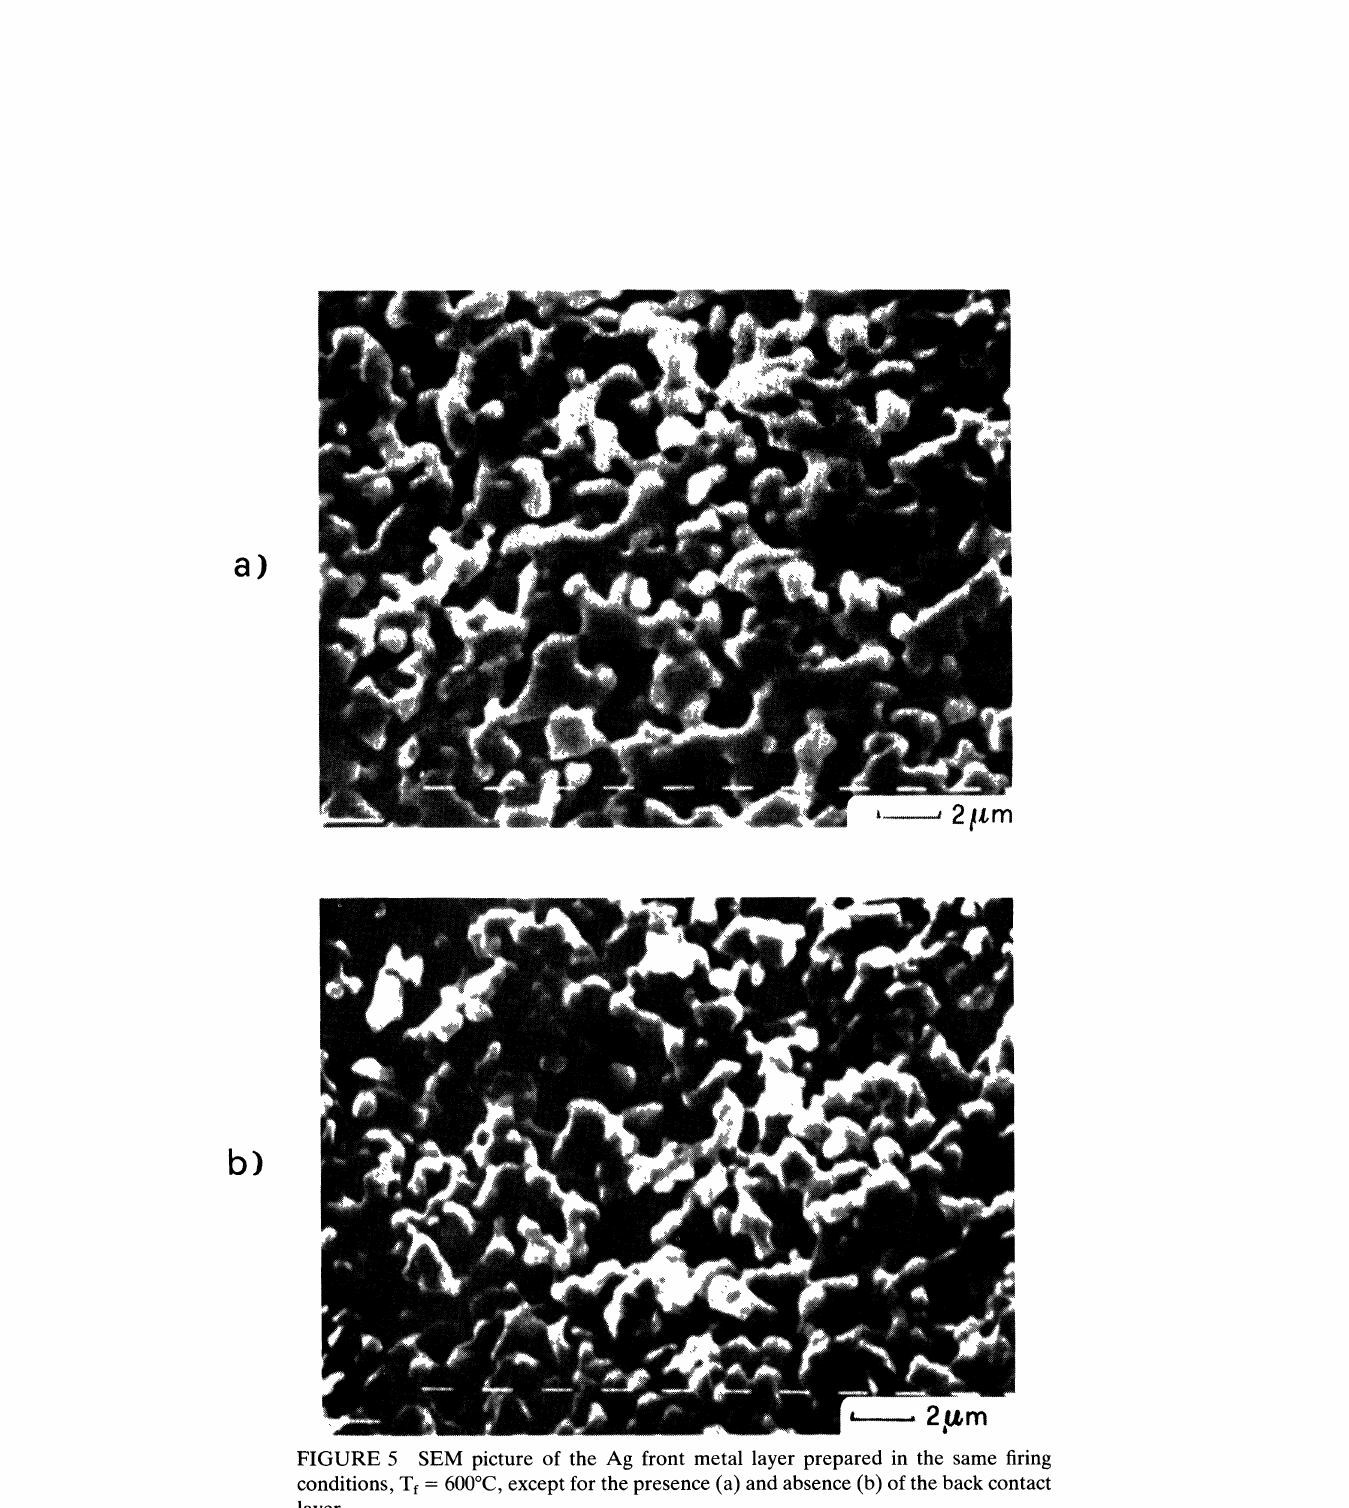
FIGURE 5 SEM picture of the Ag front metal layer prepared in the same firing conditions, Te 600C, except for the presence (a) and absence (b) of the back contact